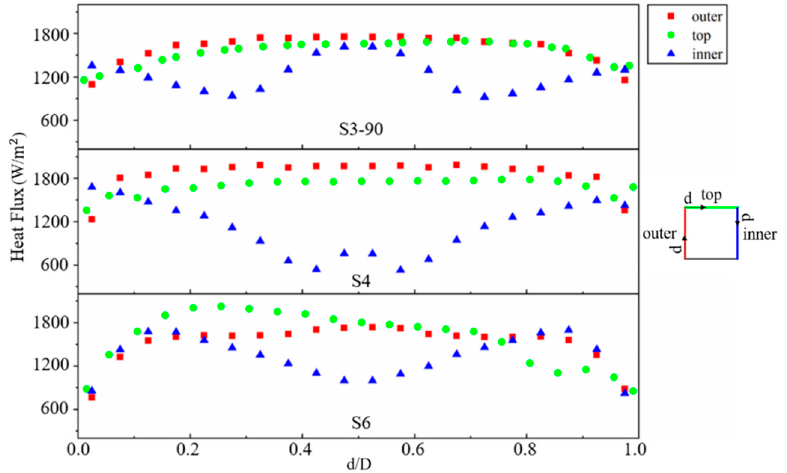
Figure 17. Local wall heat flux distribution of S3-90, S4, and S6.